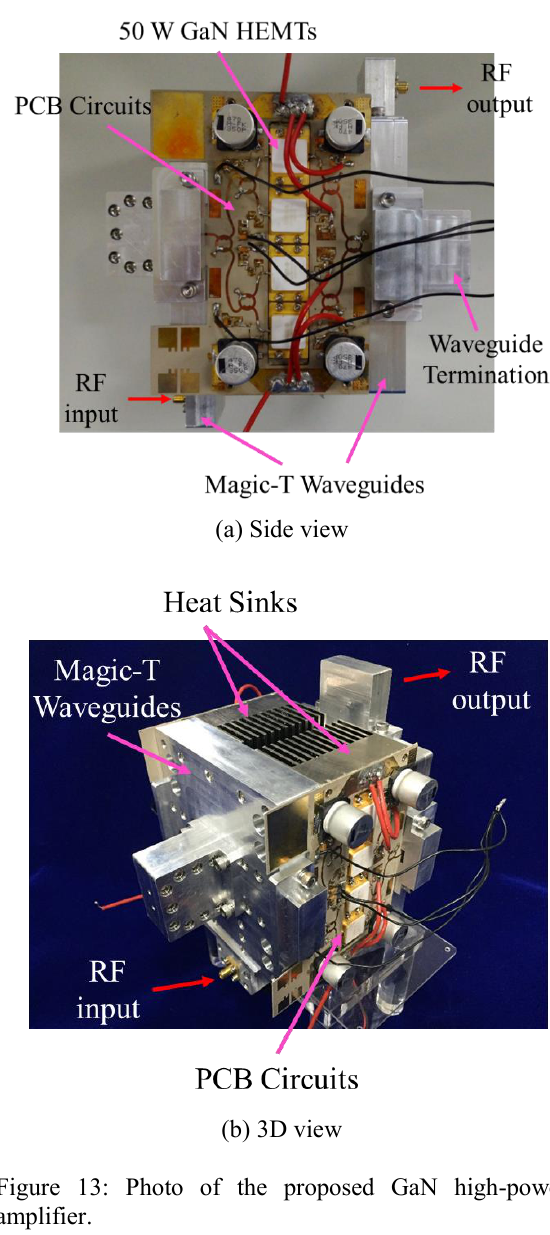
Figure 13: Photo of the proposed GaN high-power amplifier.